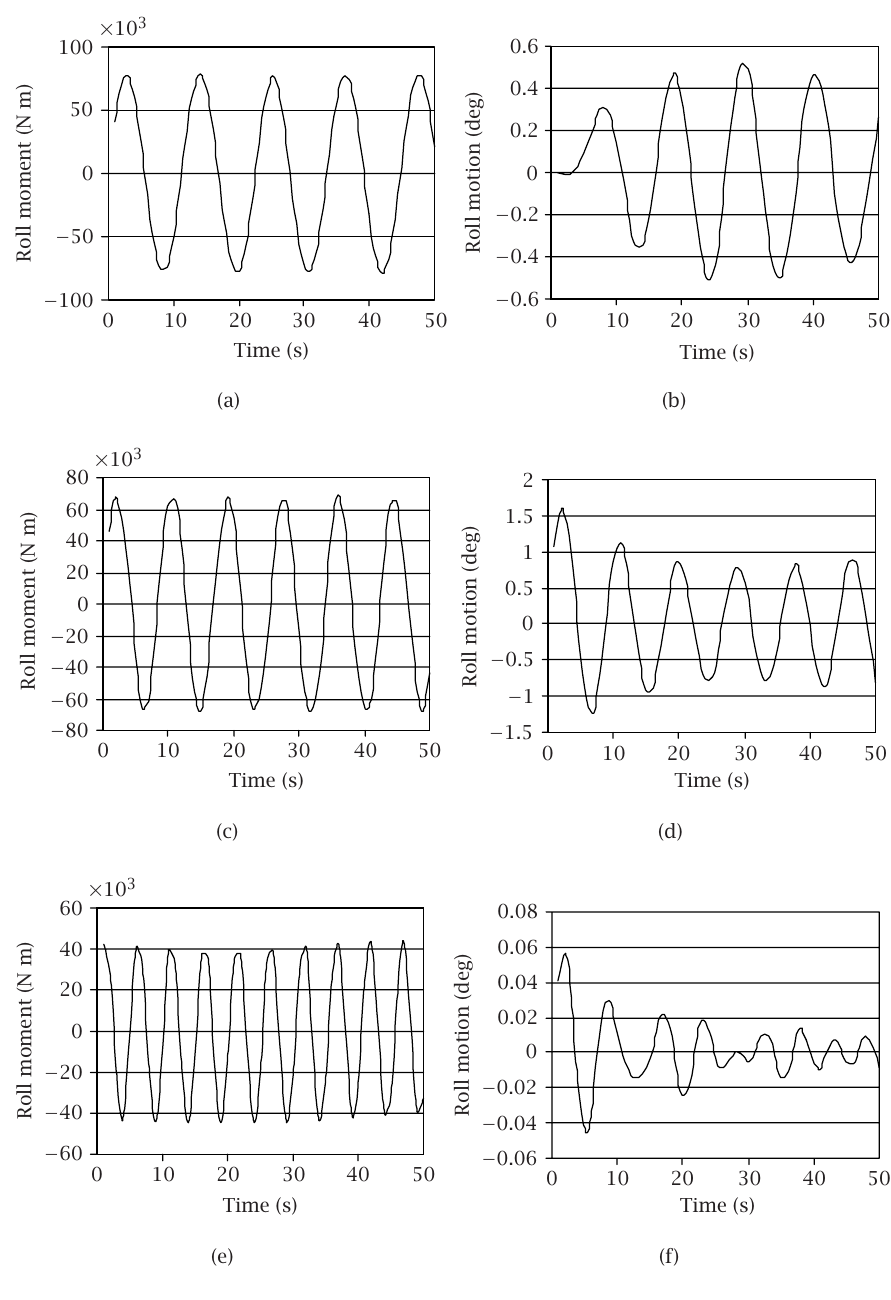
Figure 7.2 . (a, c, and e) Time history of forcing function and (b, d, f) roll motion for wave frequencies (a, b) 0.56rad/s, (c, d) 0.74rad/s, and (e, f)